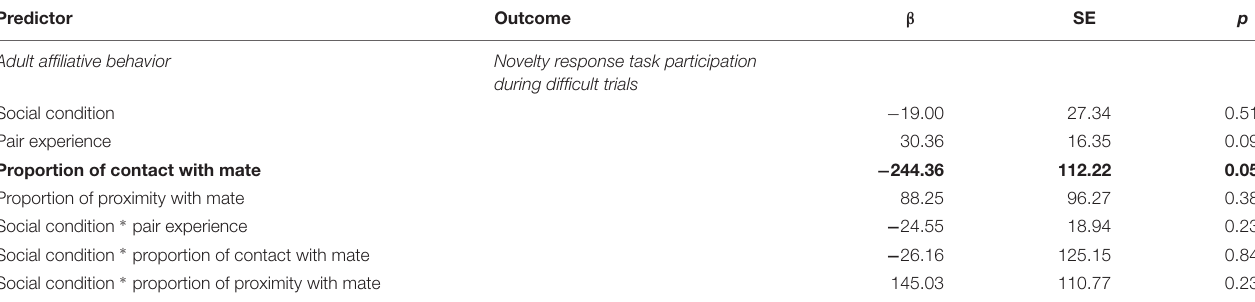
TABLE 3 | Summary of results for Experiment 1.